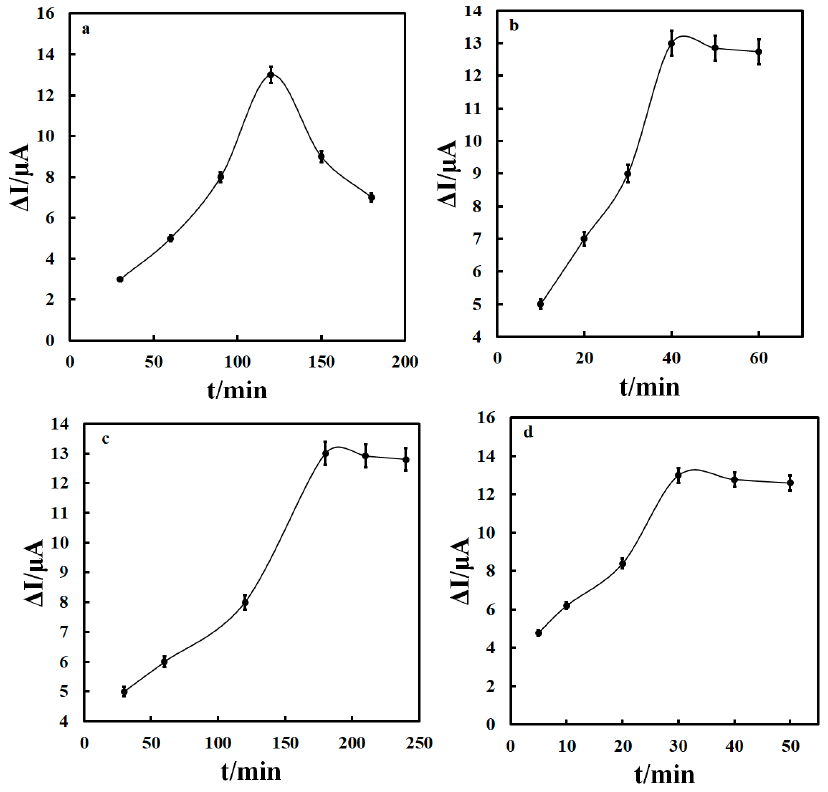
Figure 6. Optimization: ( a ) time required for attachment of aptamer to the Au electrode surface, ( b ) duration of the drug-aptamer interaction, ( c , d ) the period of the interaction between the aptamer and ox-CNO and MB, respectively.